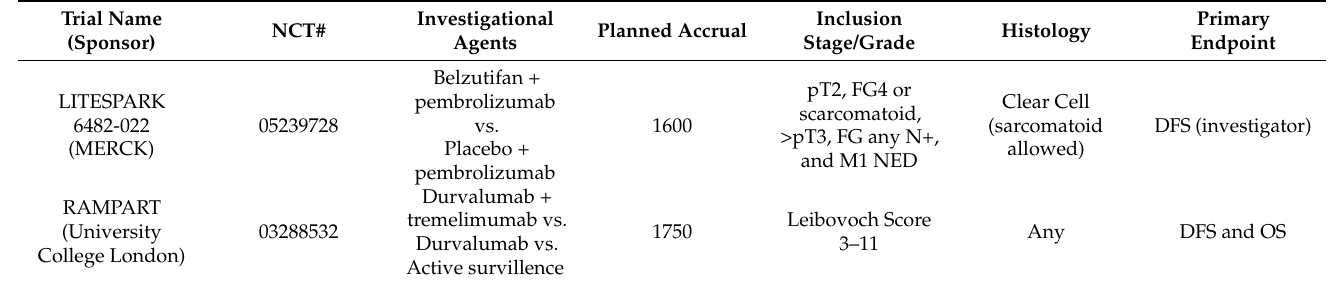
Table 5. Enrolling Neoadjuvant or Adjuvant Clinical Trials in High Risk